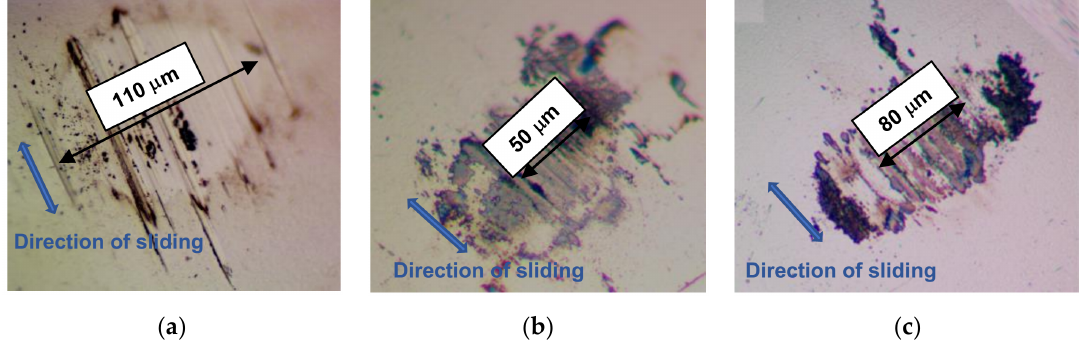
Figure 7. Optical images of wear scars formed on the steel balls after sliding against the ( a ) MoS 2 , ( b ) MoS 3 , and ( c ) MoS 4 coatings at −100 °C in the argon–air mixture (RH ~ 9%).